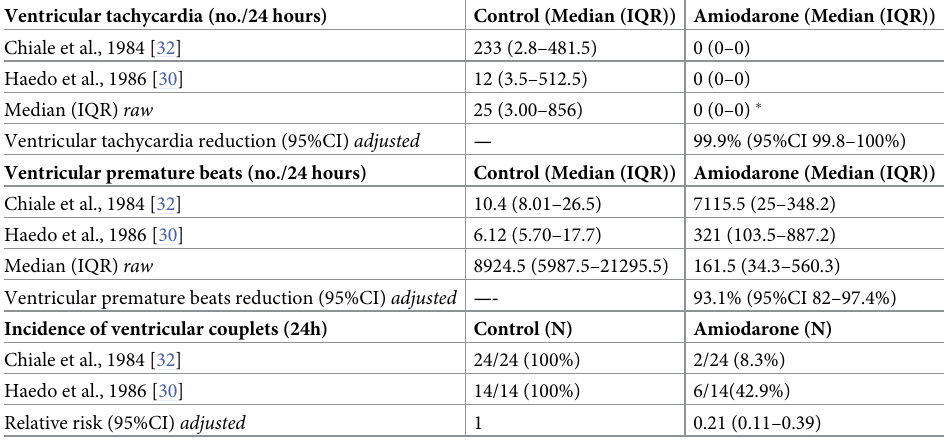
Table 3. Ventricular tachycardia, ventricular premature beats and ventricular couplets after amiodarone. Ventricular tachycardia (no./24 hours) Control (Median (IQR)) Amiodarone (Median (IQR))